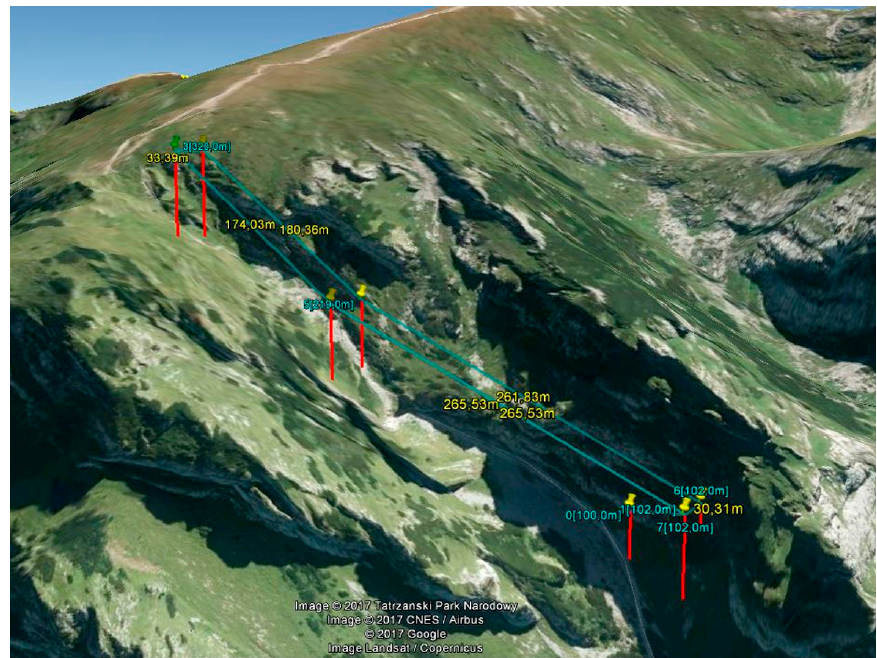
Figure 4. The UAV mission for a section of the trail from the Przys ł op Mi ę tusi glade to Ma ł o łą czniak in the area of Kobylarzowy Ż leb (source: authors’ own study). The location of the mission area is indicated by a yellow rectangle in Figure 2b. Table 1. Summary of the number of images, control and check points and flight parameters for each photogrammetric mission.